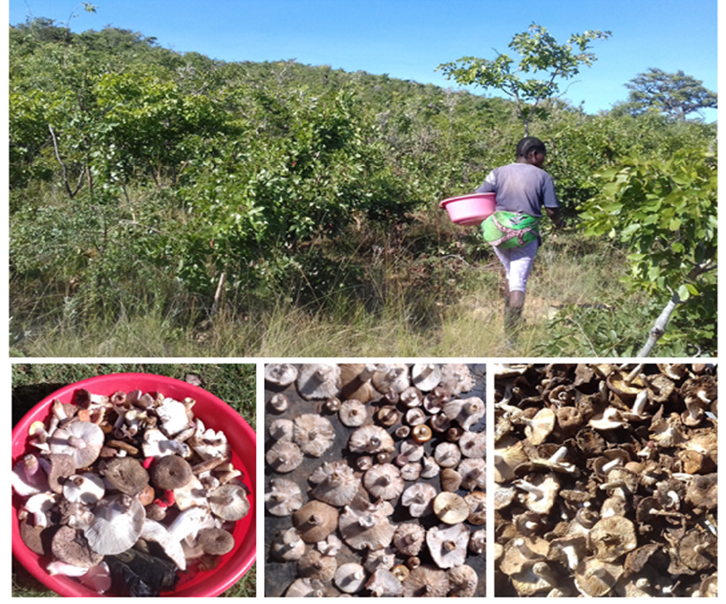
Figure 2. Mushrooms picking in a Miombo woodland area ( top ) and mixtures of fresh edible mushrooms, and mushrooms at different stages of drying ( bottom ). Photos by Herose Mendes.